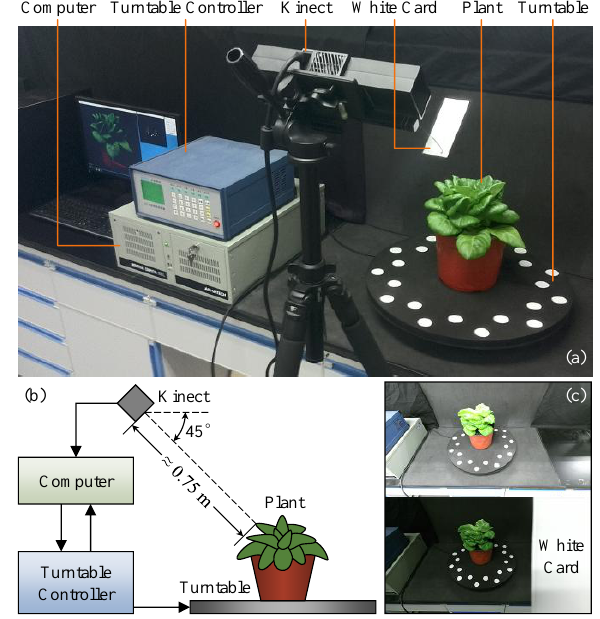
Figure 1. Platform of our system ( a ), relationship of each component ( b ) and effect of the white card ( c ). The arrows in ( b ) represent data flow directions.